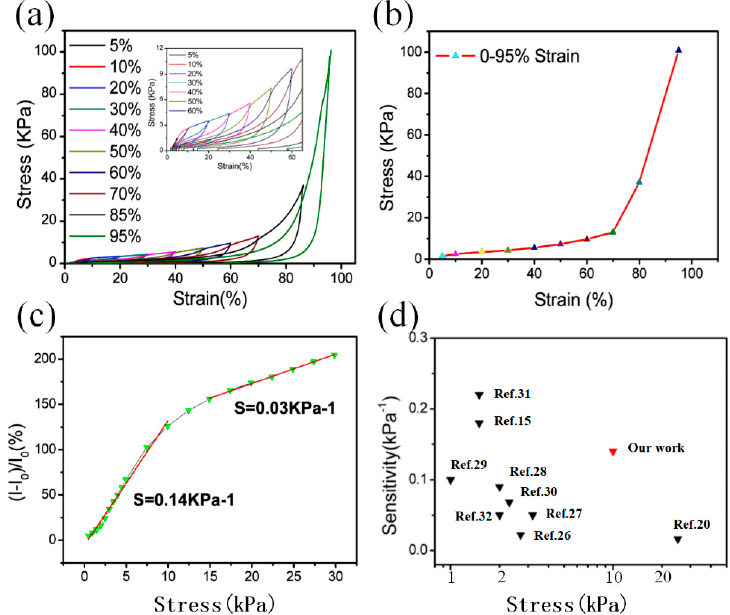
Figure 4. ( a ) The stress-strain curves of the three-dimensional graphene composite foam (GSBF) composite with 0 to 95% strain, inside of ( a ) is an enlarge figure ( b ) The stress–strain curve of GSBF (graphene oxide (GO): graphene-SiO2 balls (GSB) ratio of 10:1) with 0–95% strain. ( c ) Resistance response at different frequencies under 30% strain. ( d ) The comparison of sensors in previous reports and this work [15,20,26–32].